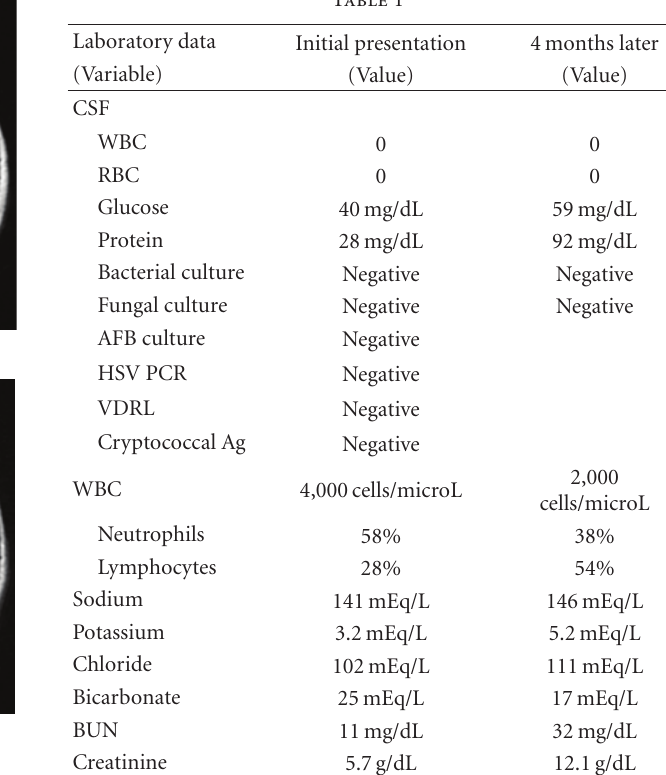
Figure 1: (a) At presentation: axial T2-weighted fluid-attenuated inversion recovery MRI showed multiple large areas of edema in the occipitoparietal regions. (b) At presentation: axial T2- weighted FLAIR MRI showed multiple large areas of edema in the occipitoparietal lobe, with the right greater than the left with no mass e ff ect. (c) At 2-week followup: axial T2-weighted FLAIR MRI showed resolving edema. (d) At 5-month followup: axial T2- weighted FLAIR MRI showed no further edema.